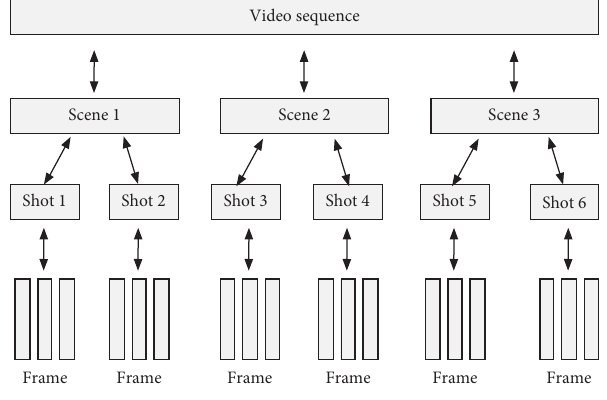
Figure 1: The structure of video